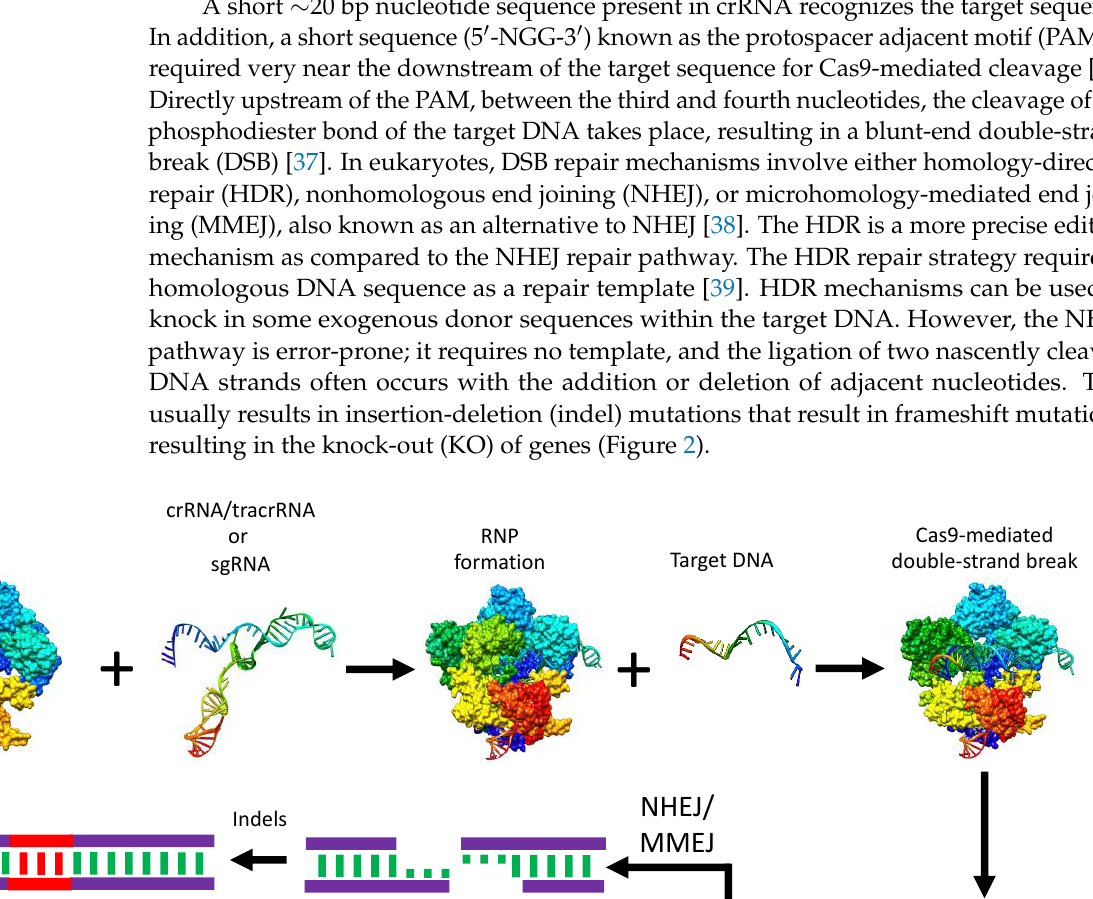
Figure 1. Domain organization of SpCas9 and three-dimensional structure of SpCas9-sgRNA-DNA ternary complex shown by ( a ) domain organization of Cas9, ( b ) ribbon representation, and ( c ) space- filling model, obtained from protein data bank (PDB) at https://www.rcsb.org (accessed on 12 Janu- ary 2023), PDB ID: 4OO8 and edited by UCSF Chimera.